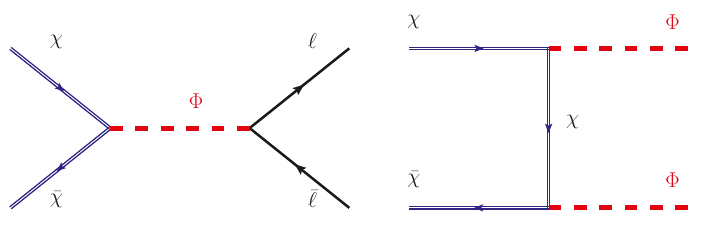
Figure 1 . Feynman diagrams for LDM